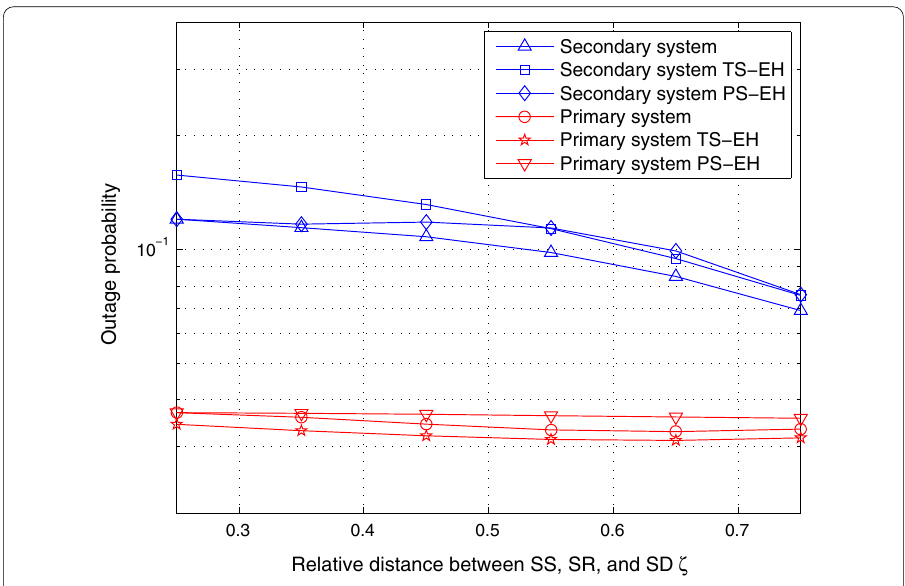
Fig. 7 Outage probability versus the relative distance between SS, SR, and SD